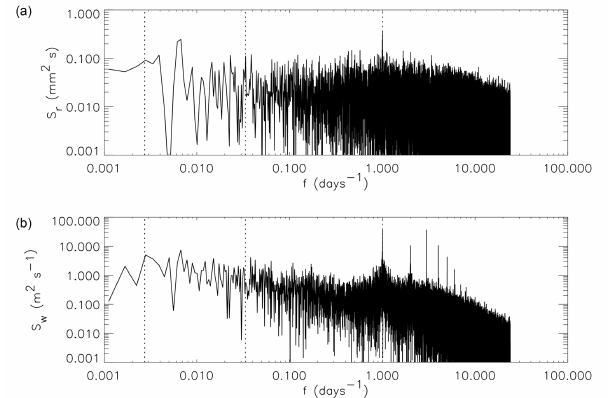
Figure 4. (a) Power spectrum of half-hourly rainfall amount ( S r , mm 2 s) and (b) power spectrum of half-hourly mean wind speed ( S w , m 2 s − 1 ), both for the period from 13 September 2012 to 14 Au- gust 2017. The vertical dotted lines mark frequencies ( f , days − 1 ) corresponding to 1, 30 and 365 days. Both plots show a distinct peak at the daily frequency, with the wind speed also exhibiting several sub-daily peaks.